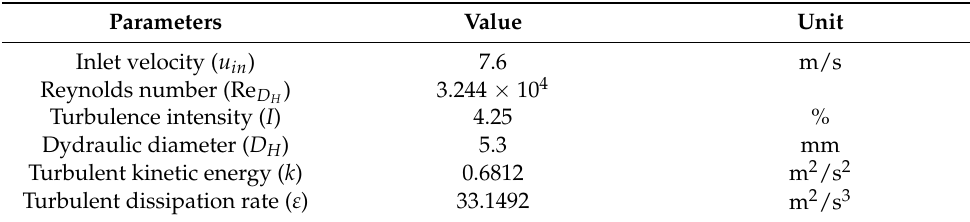
Turbulent kinetic energy ( k ) Turbulent dissipation rate ( ε